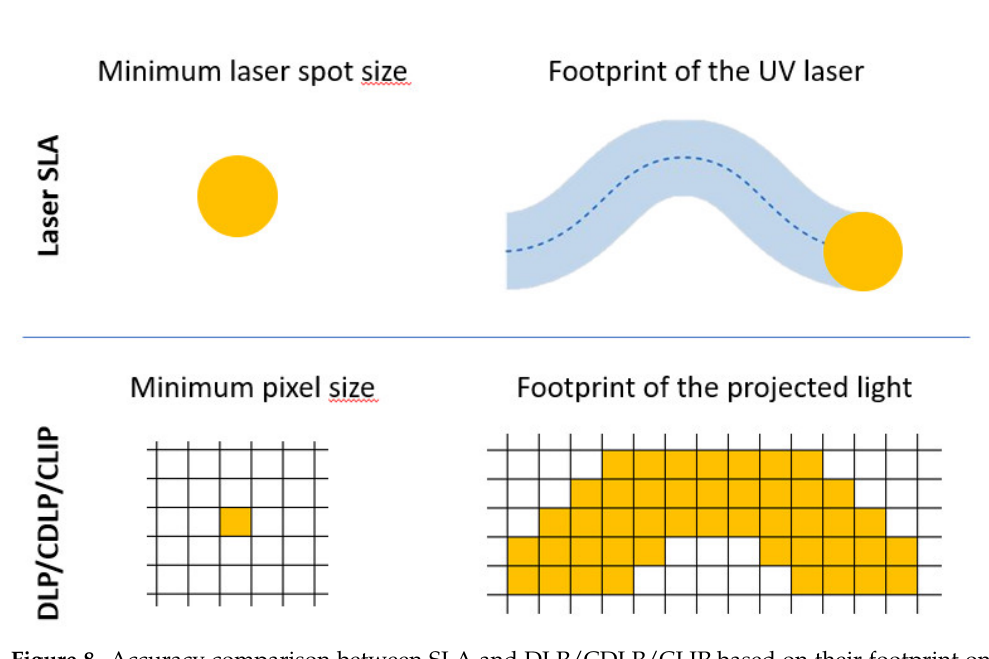
Figure 8. Accuracy comparison between SLA and DLP/CDLP/CLIP based on their footprint on building platform, namely, the xOy plane [24].